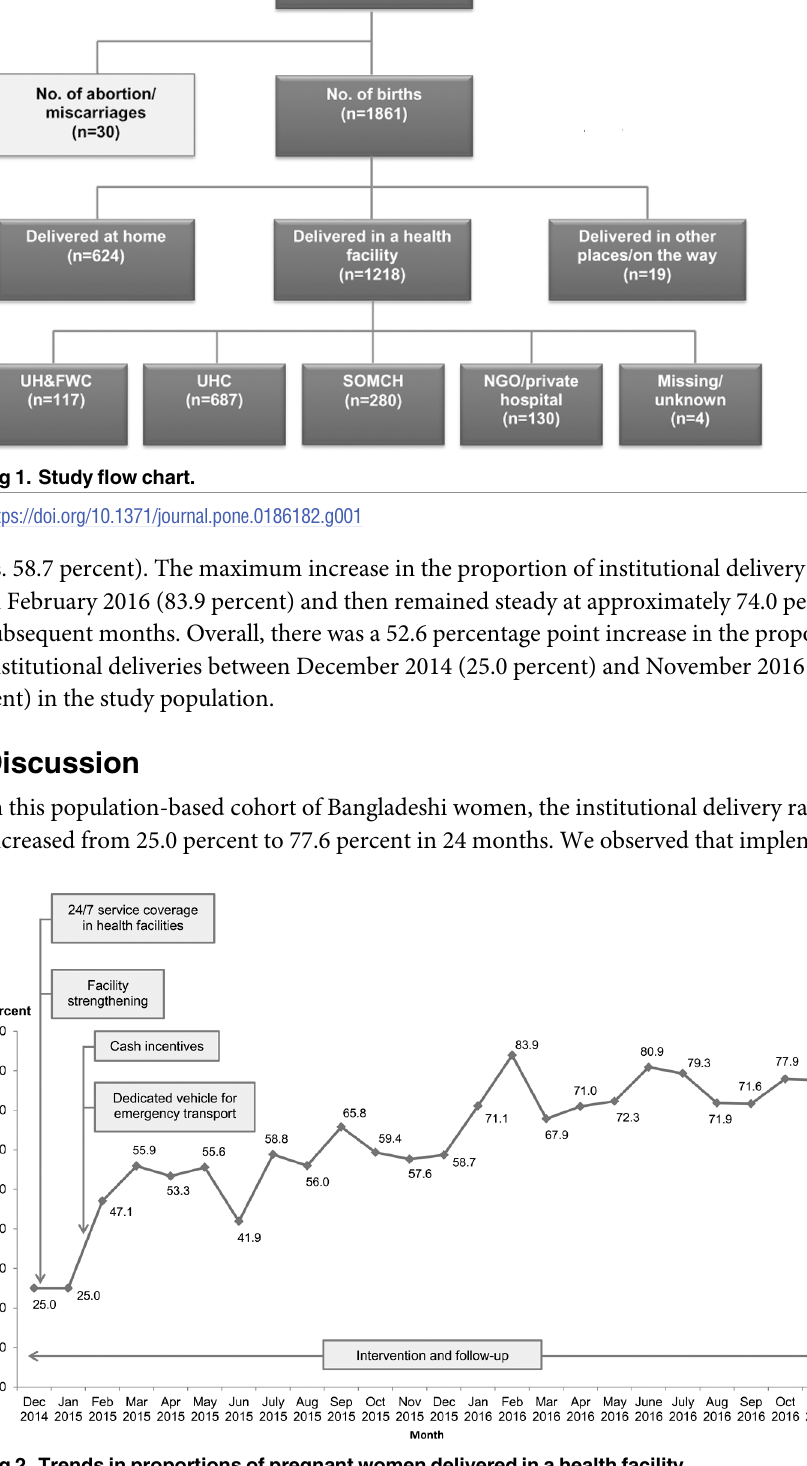
Fig 2. Trends in proportions of pregnant women delivered in a health